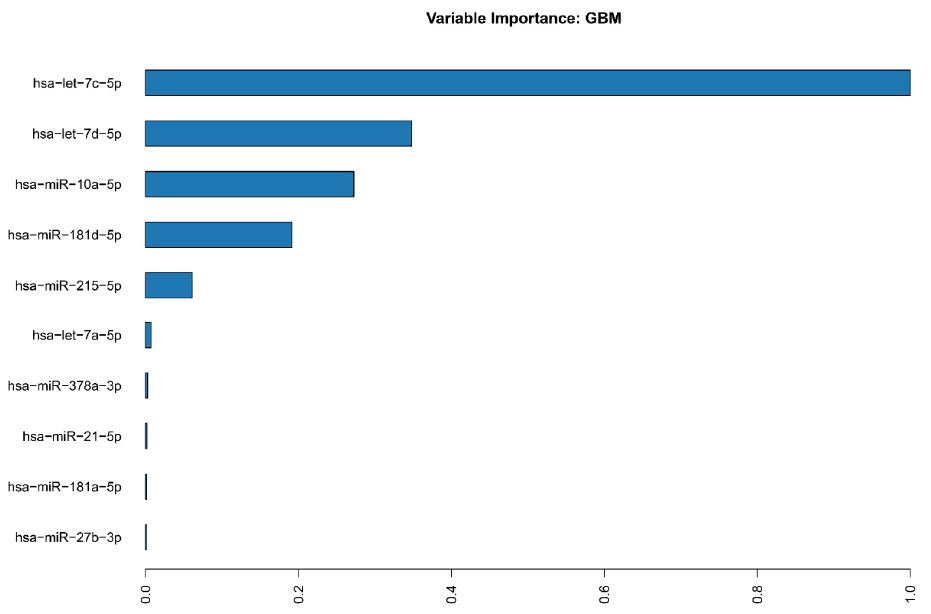
Figure 2. Top 10 miRNAs tagged as important variables for our GBM ML model.